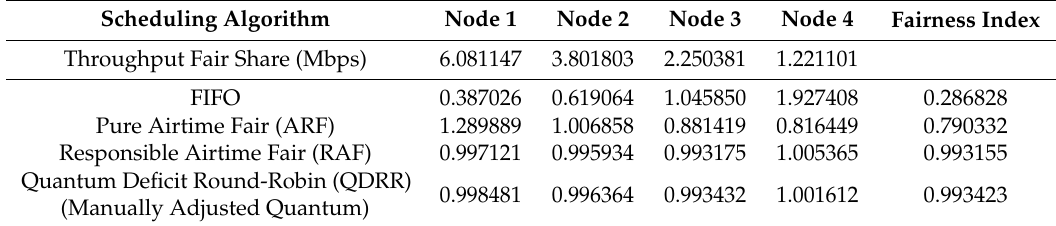
Table 5. Throughput Achieving Ratio and Fairness Index in UDP Traffic.